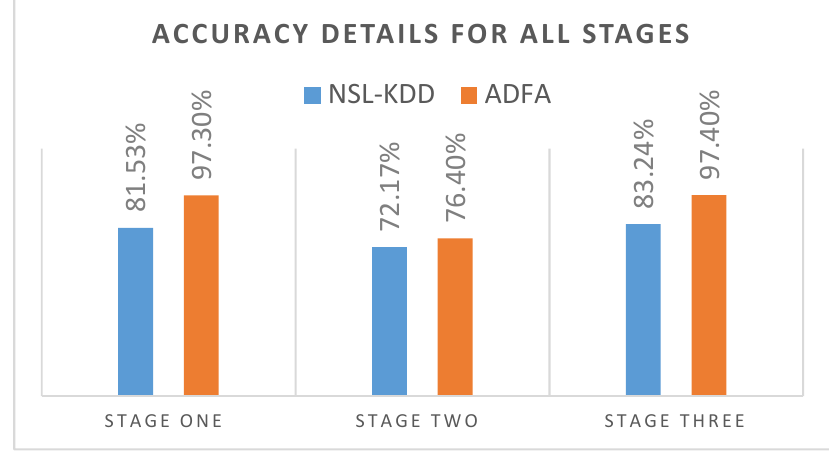
Figure 6. Accuracy details for all stages. Table 18. Performance comparison between different classifiers and proposed algorithm on KDDTest+.